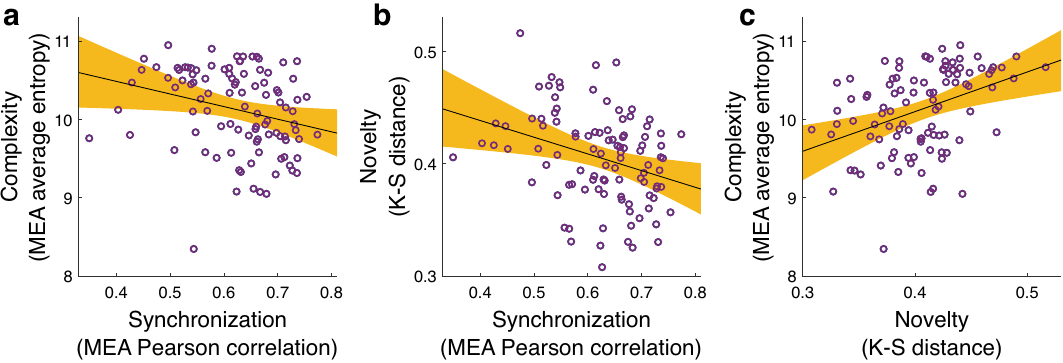
Figure 3. A tradeoff between synchronization and being interested. Pearson correlations between the different movement measures. In each panel each circle represents a dyad, and the black line is the linear regression line. The orange area marks the confidence interval around the slope of a regression line. ( a ) Negative correlation between complexity and synchronization, r = − 0.27, permuted P = 0.007, P = 0.003, 95% CI = [− 0.44, − 0.08], BF 10 = 4.252. ( b ) Negative correlation between novelty and synchronization, r = − 0.32, P = 0.001, permuted P < 0.001, 95% CI = [− 0.48, − 0.13], BF 10 = 21.88. ( c ) Positive correlation between complexity and novelty, r = 0.39, P < 0.001, permuted P < 0.001, 95% CI = [0.21, 0.54], BF 10 =